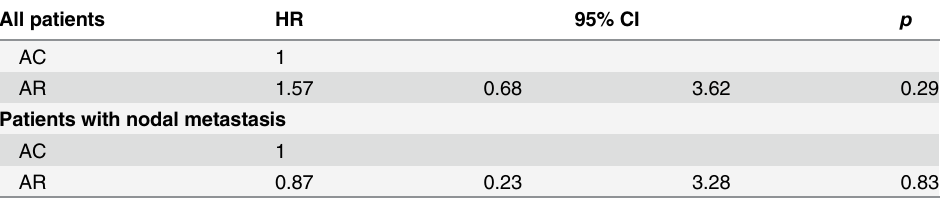
Table 5. Comparison of recurrence between the AC and AR treatment arms by the Cox proportional hazard model using the inverse-probability-of-treatment weighting method. All patients HR 95% CI p AC 1 AR 1.57 0.68 3.62 0.29 Patients with nodal metastasis AC 1 AR 0.87 0.23 3.28